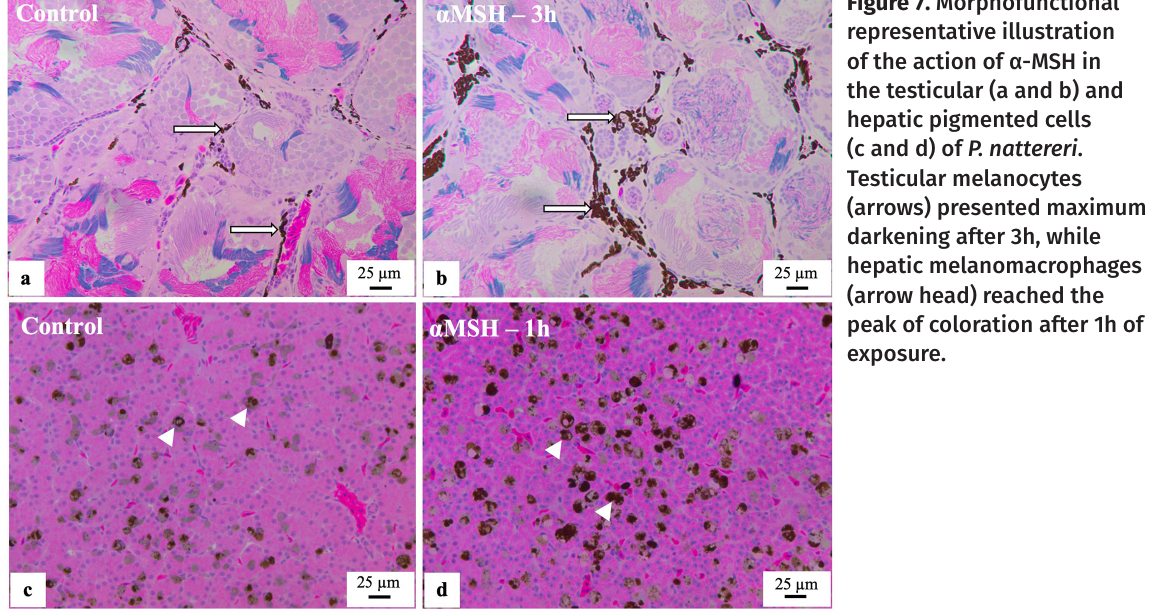
Figure 7. Morphofunctional representative illustration of the action of α-MSH in the testicular (a and b) and hepatic pigmented cells (c and d) of P. nattereri . Testicular melanocytes (arrows) presented maximum darkening after 3h, while hepatic melanomacrophages (arrow head) reached the peak of coloration after 1h of